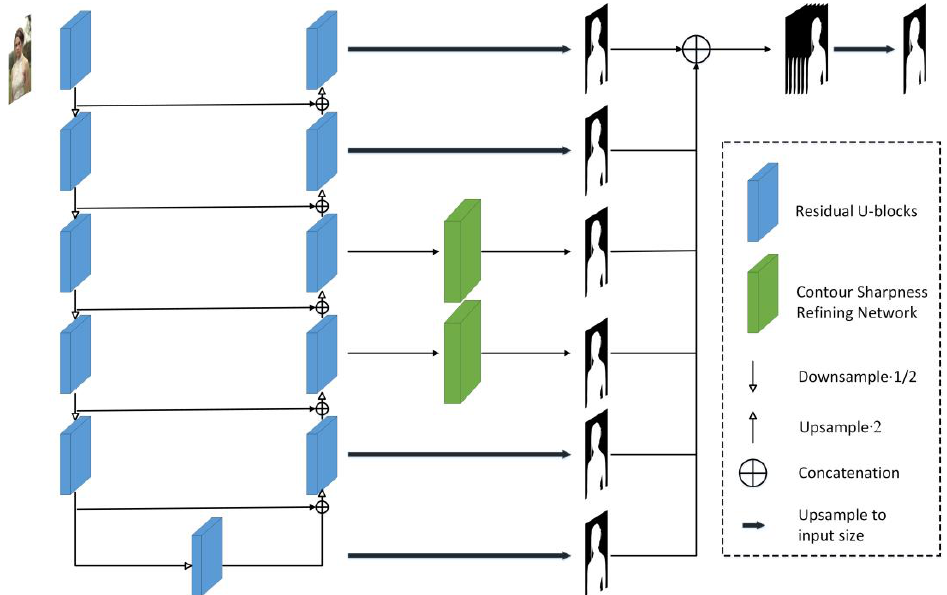
Figure 2. Network